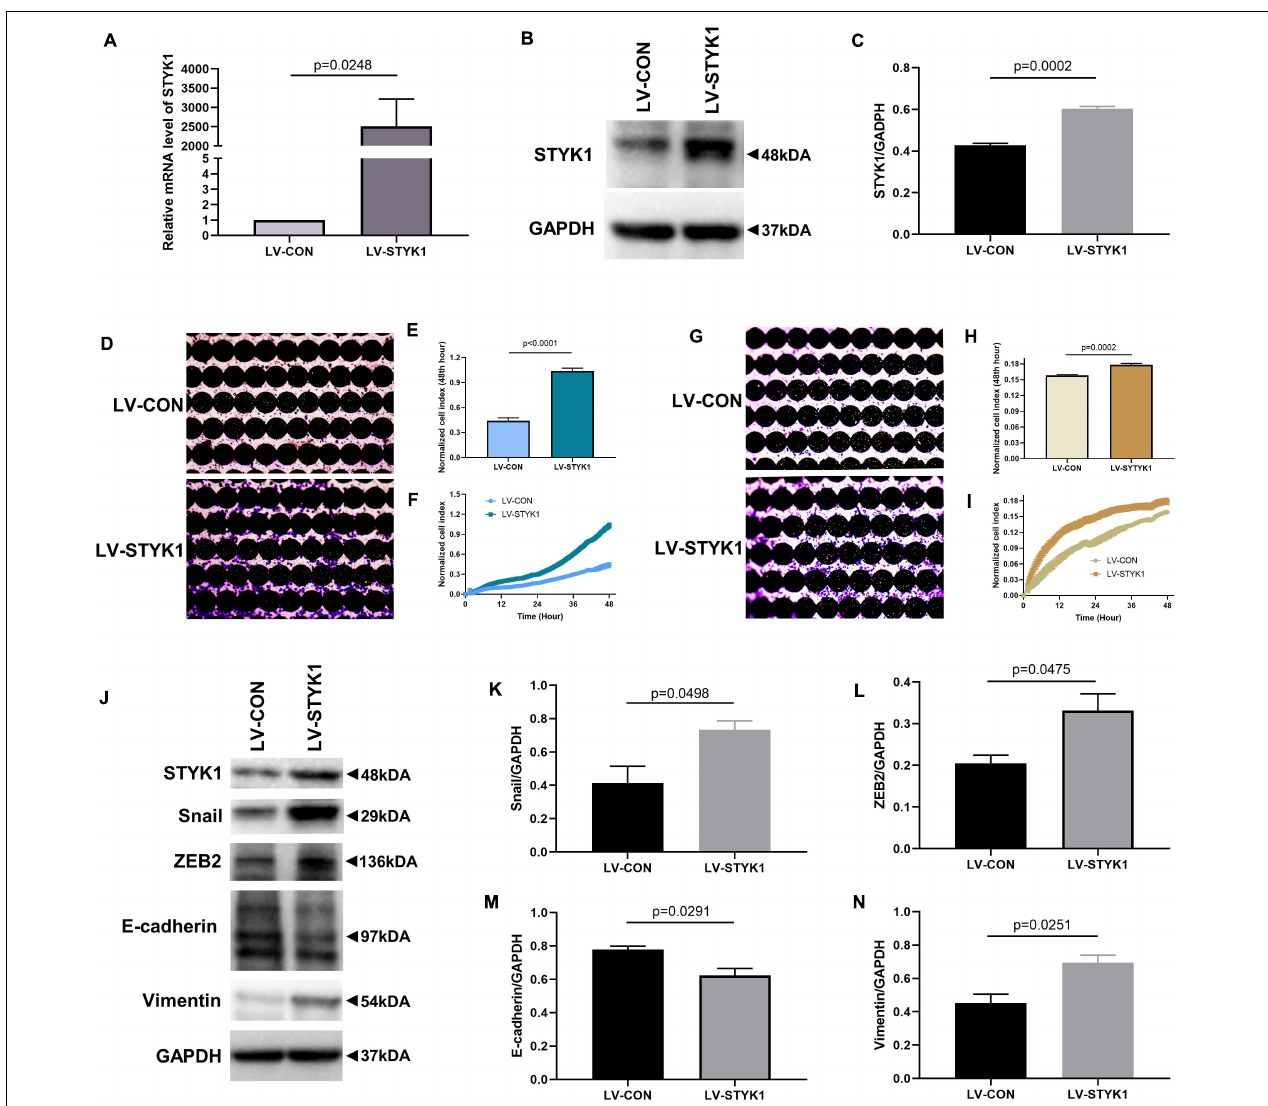
FIGURE 2 | STYK1 overexpression upregulates migration, invasion, and EMT in SW900 cells. (A–C) (Lai et al., 2019) STYK1 expression in SW900 cells after transduction with STYK1 encoding lentiviruses; P = 0.0248 and P = 0.0002, Student’s t -test. (D) Capacity for cell migration after transduction with lentiviruses encoding STYK1; cells were stained with crystal violet at the endpoint of RTCA. (E) Normalized cell index after lentiviral STYK1 overexpression at the endpoint of RTCA; P < 0.0001, Student’s t -test. (F) Cell index curves after lentiviral STYK1 overexpression. (G–I) Cell invasion capacity after lentiviral STYK1 overexpression evaluated by RTCA and crystal violet staining; P = 0.0002, Student’s t -test. (J–N) Typical immunoblots and semiquantitative analysis of EMT biomarkers after transduction with lentiviruses encoding STYK1; P = 0.0498, P = 0.0475, P = 0.0291, and P = 0.0251, Student’s t -test. LV-CON, control SW900 cells; LV-STYK1, SW900 cells with lentiviral STYK1